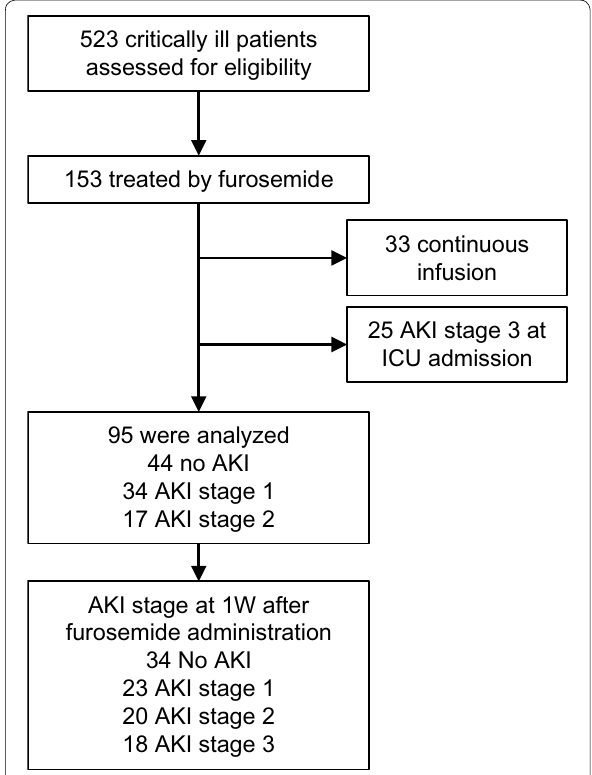
Fig. 1 Study flow